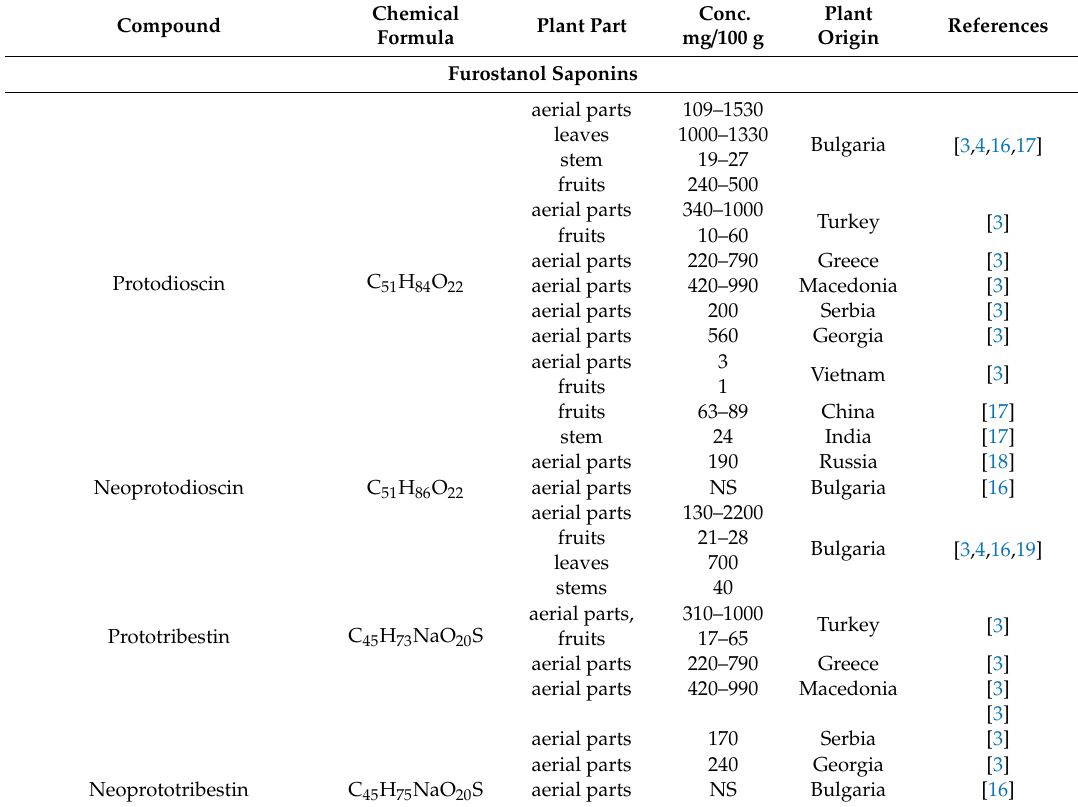
Table 2. Chemical compounds identified in Tribulus terrestris (TT).